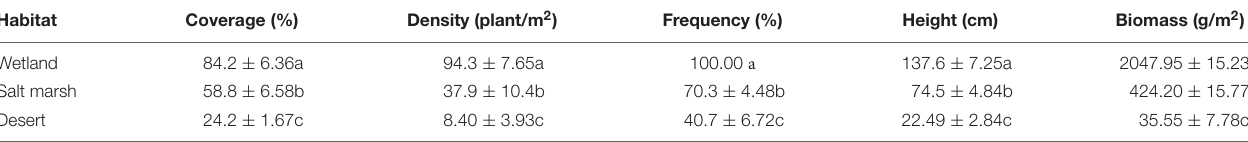
TABLE 1 | Characteristics of P. australis populations in the different habitats. Habitat Coverage (%)